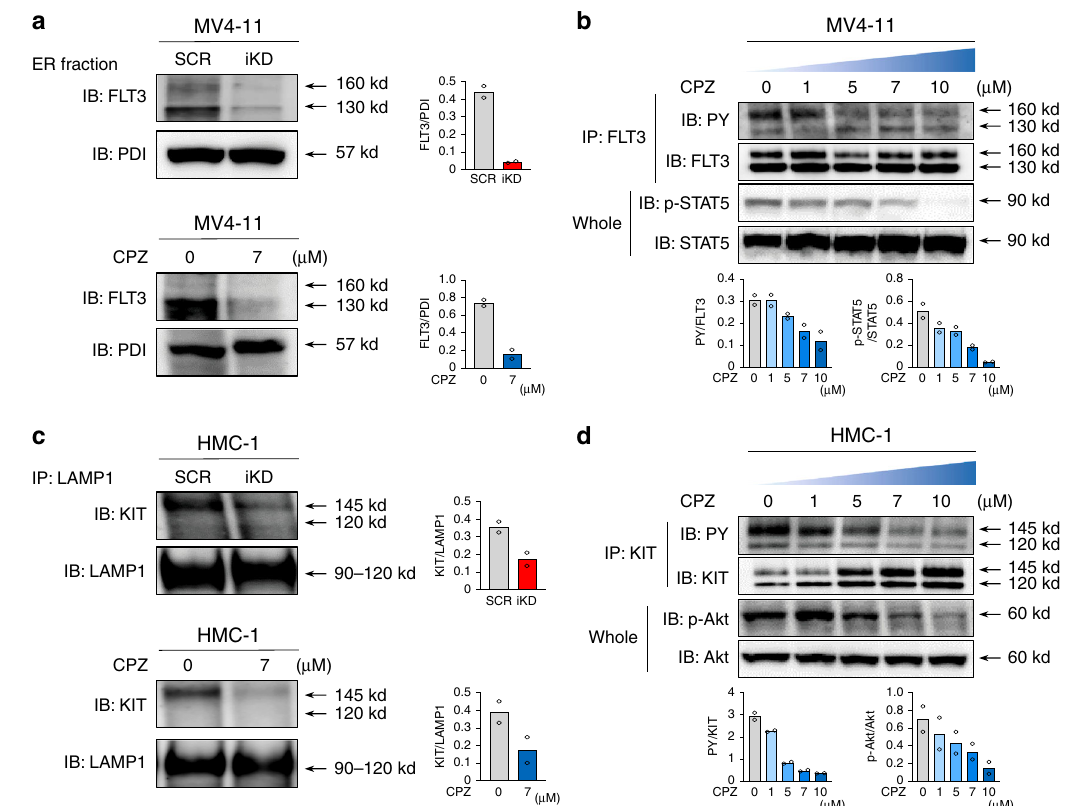
Fig. 5 CPZ blocks compartment-dependent oncogenic signaling from MT-RTKs. a PDI-positive ER fraction was isolated from CALM iKD, CALM SCR, CPZ- treated, and CPZ-untreated MV4-11 cells and subjected to immunoblot analyses. b MV4-11 cells were cultured with CPZ at the indicated concentrations for 18 h. Whole cell lysates or immunoprecipitated proteins were isolated and subjected to immunoblot analyses with the indicated Abs. c LAMP-1-positive protein was immunoprecipitation from the total lysates of CALM iKD, CALM SCR, CPZ-treated, or untreated HMC-1 cells, and subjected to immunoblot analyses using the indicated Abs. d HMC-1 cells were cultured for 24 h with or without CPZ at the indicated concentration, Phosphorylated status of KIT and Akt was assessed by immunoblot analyses on the whole lysates or immunoprecipitated proteins. These densitometry analyses were carried out using Image Quant TL, and data are from two independent (Supplementary Fig. 7a). As a result, the mean %hCD45 + cells was 26.1% in control mice and 29.3% in CPZ-treated mice